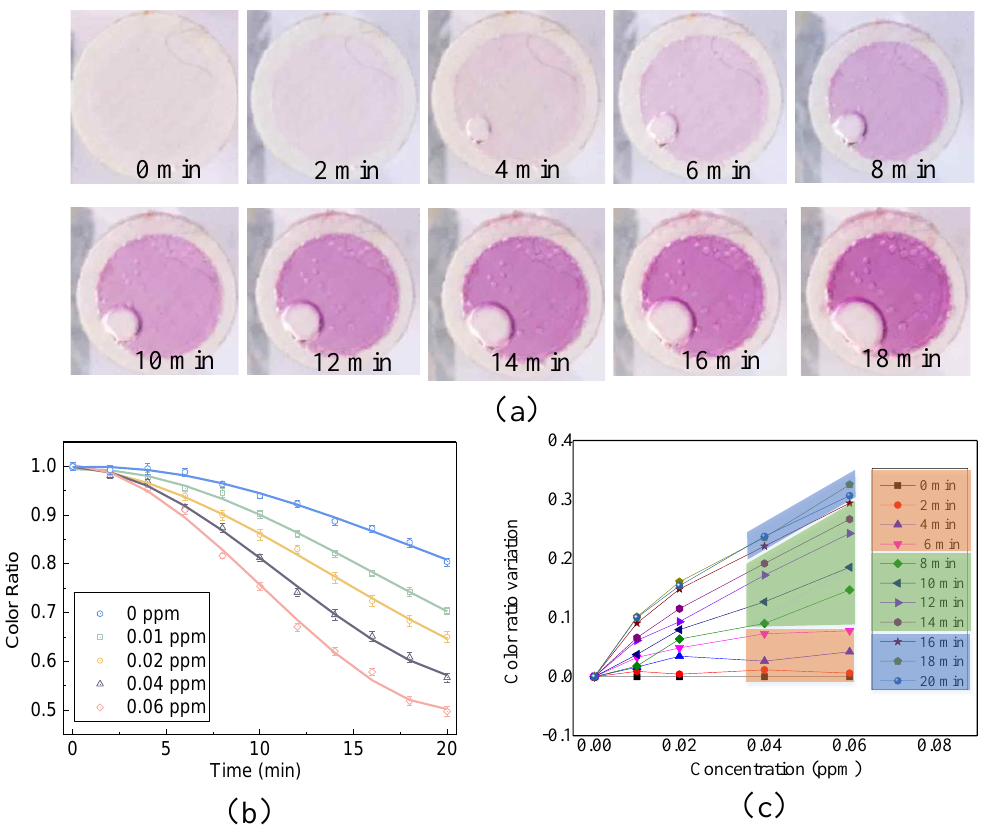
Figure 4. ( a ) Photographs of the reaction reservoir at different times. The concentration of the formaldehyde is 0.06 ppm. ( b ) Relationship between sampling time and color ratios at various concentrations of formaldehyde. ( c ) The color ratio variation relating to the color ratio at 0 ppm.